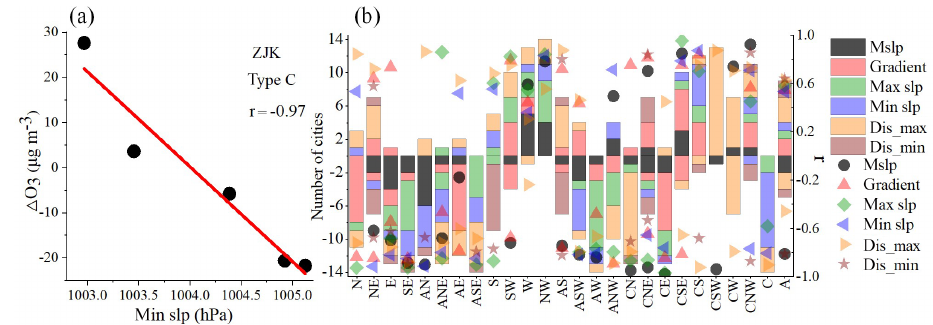
Figure 7. Scatterplot of (cid:49) O 3 versus min slp for weather type C in ZJK (a) . The red line represents the linear fitting between min slp (the ECII under weather type C in ZJK) and (cid:49) O 3 (the difference between the MDA8 O 3 for a given year and the corresponding 5-year average); r represents the correlation coefficient. The number of cities (histogram) and averaged correlation coefficient r (points of different shapes) according to corresponding ECII under each weather type among 14 cities (b) . The number of cities with positive or negative values represents positive or negative correlations between ECII and (cid:49) O 3 . For example, under CW controls, there are one, six and seven cities where ECII corresponds to mslp with a positive correlation, dis max with a positive correlation and dis max with a negative correlation, respectively, and the average r is 0.74, 0.70 and − 0 . 79,